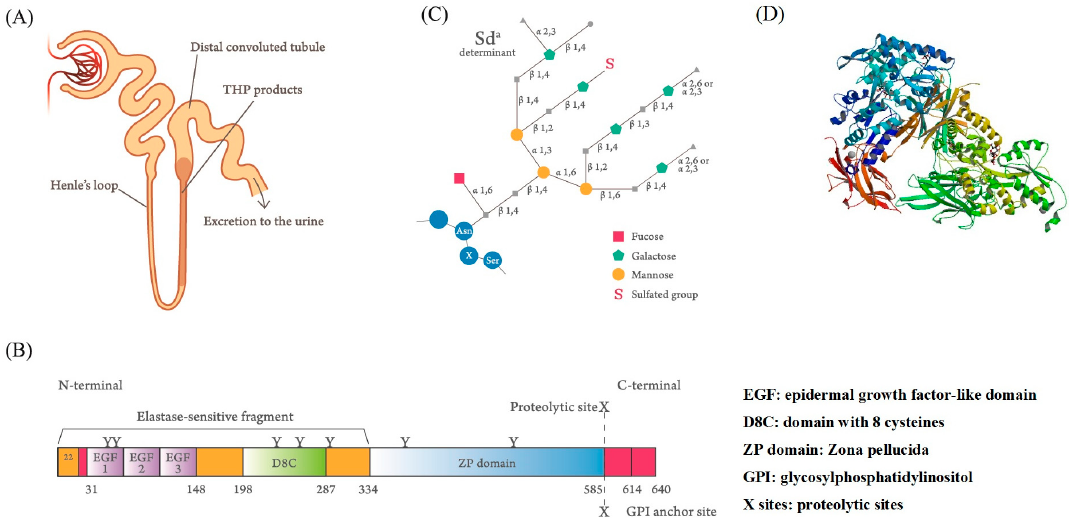
Figure 1. Synthesis site, protein domain structure, and fine tetra-antennary carbohydrate compositions of normal human Tamm–Horsfall protein (THP). ( A ) The thick ascending limbs of the loop of Henle in the nephrons are the essential synthesis sites of THP. The molecule is directly excreted into the urine stream after production. ( B ) The domain structure of the THP molecule shows 3 epidermal growth factor (EGF)-like domains (marked by EGF-1, EGF-2, EGF-3), 7 N -glycosylation sites (marked by Y), and a proteinase cleavage site (marked by X) (adapted from Li et al. [36]). ( C ) Fine tetra-antennary carbohydrate composition of THP and its binding site with the blood substance Sd a (from Serafini-Cessi et al. [37]). ( D ) 3-D structure of THP (from Bokhove et al. [38]).The full names of the abbreviations in the scheme are as follows: α 1,3: Sia α (1,3)-galactose/ N -acetylgalactosamine;